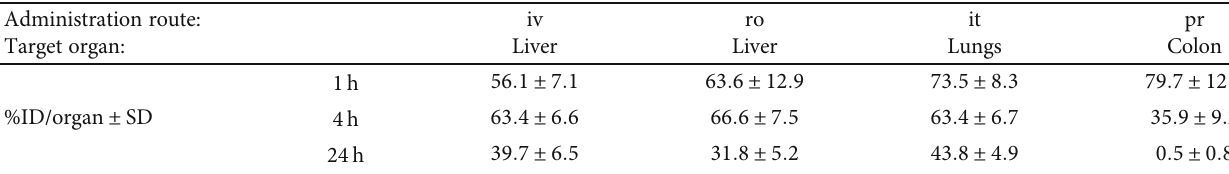
Table 4: % ID per organ calculated through VivoQuant ™ , for the target organs of each administration route, based on the images presented on Figure 9. Average values ± SDs are presented based on minimum 2 animals per time